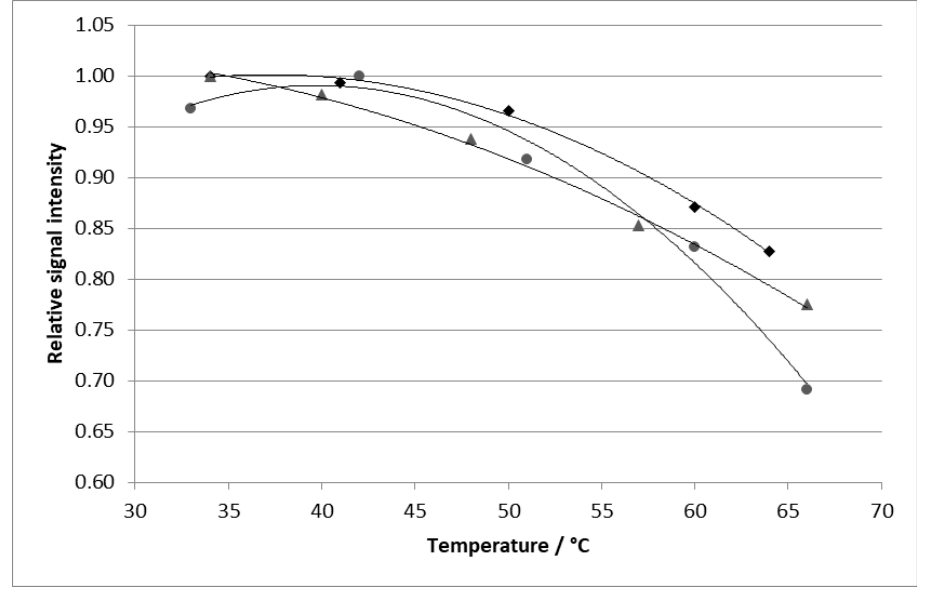
Figure 3. Relative luminescence intensity of chelate 1b (square), 6b (triangle) and 8b (circle) vs. measurement temperature.